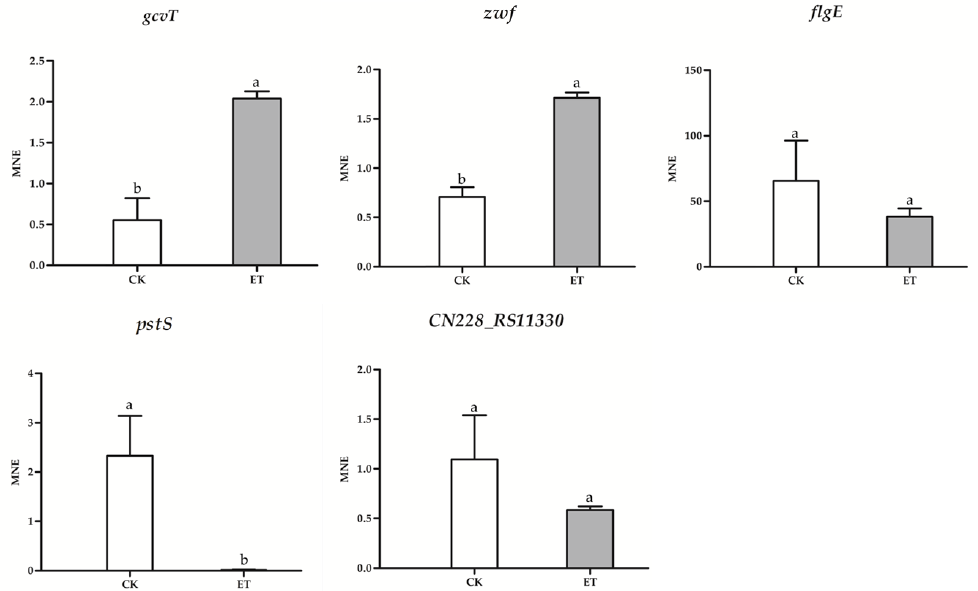
Figure 10. The qRT-PCR results. The data represent the means ± SD of three replicate samples (ET represent the average treatment of ethylicin at 3.6 μg/mL). Different letters (a–c) indicate signifi- cant differences at p < 0.05.